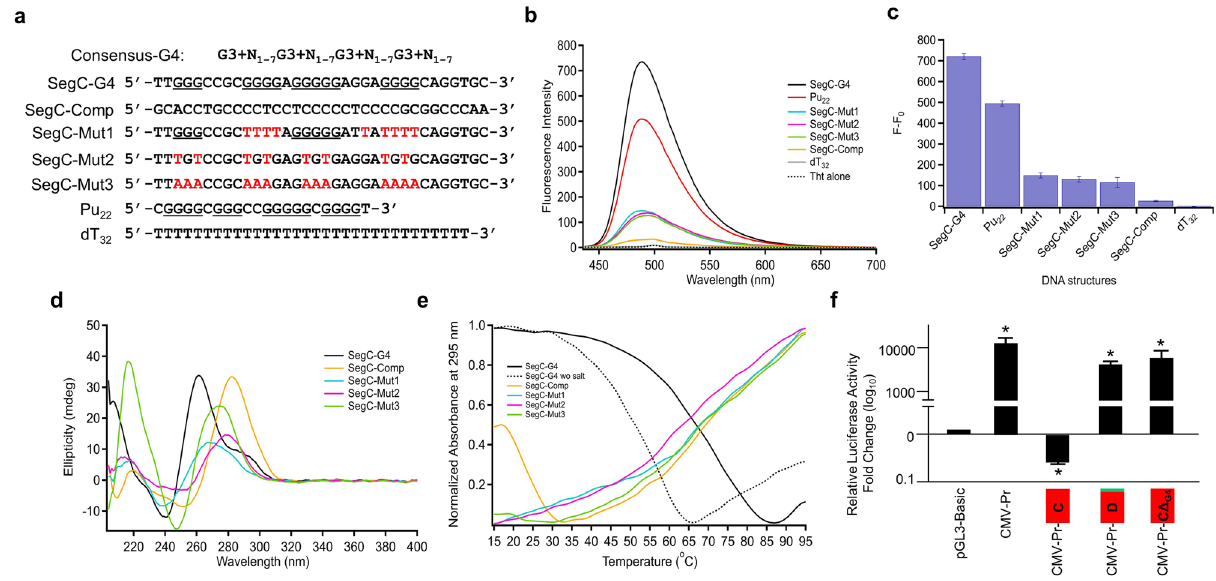
Figure 7. Segment C of Exon3 may contain a G-quadruplex. ( a ) Wild-type and mutant oligonucleotides (red font) of Segment C together with Pu 22 of VEGF with possible G4 forming sequences (underlined) are shown. ( b , c ) Assessing the presence of a G4 structure in Segment C using Thioflavin T (ThT). ( b ) Fluorescence emission of ThT in the presence of selected nucleic acid sequences ( c ) bar graph of the change in ThT fluorescence in the presence of selected nucleic acid sequences. ( d ) CD spectra of Segment C oligonucleotides at 5 °C. ( e ) Thermal denaturation profile of Segment C oligonucleotides obtained from the change in UV–Vis absorbance at 295 nm between 15 to 95 °C. ( f ) MCF7 cells were transiently transfected with pGL3 bearing none (Basic-Luc), the CMV promoter without (CMV-Pr), or with the 3 ′ -end genetically fused Segment C (CMV-Pr-C), Segment D (CMV-Pr-D), or Segment C bearing the G4 sequence deletion (CMV-Pr-CΔ G4 ). Reporter vectors drive the expression of the Firefly Luciferase cDNA expression as the reporter enzyme. The transfection efficiency was monitored by the co-expression of pCMV-RL that drives the expression of the Renilla Luciferase cDNA. 24 h after transfections, cellular extracts were subjected to dual-luciferase assays. Shown are the mean ± SE of three independent experiments performed in triplicate. Firefly/ Renilla Luciferase activities are presented as fold change (log 10 ) compared to pGL3-Basic, which is set to one. Asterisk (*) indicates significant differences from the Basic-Luc